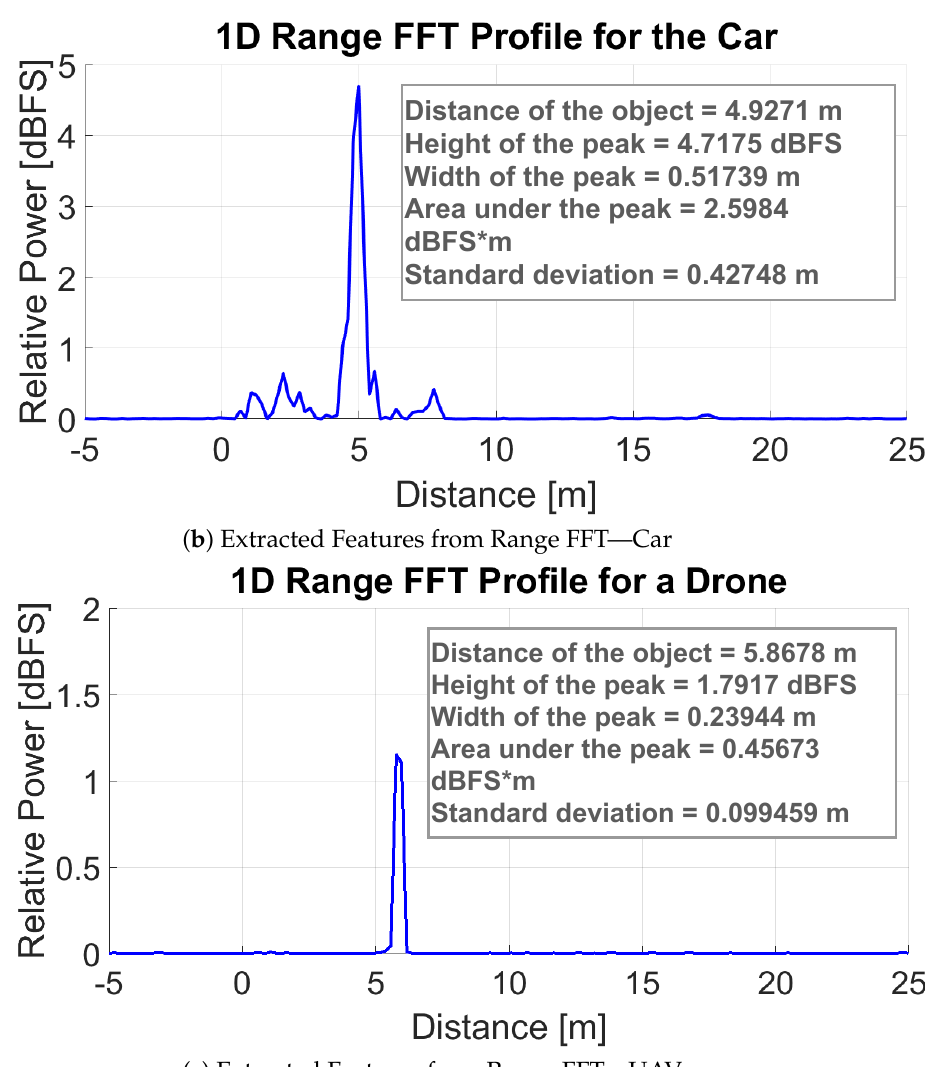
Figure 8. Features extracted in the range FFT profile.